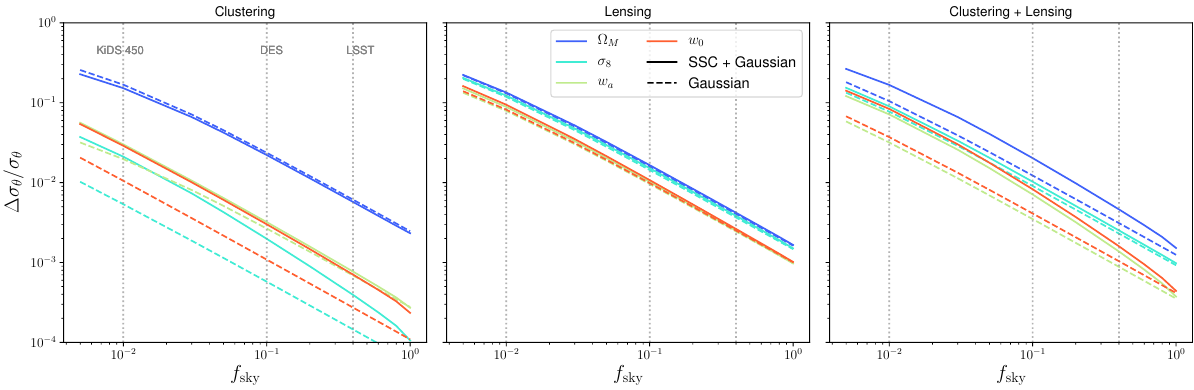
FIG. 3: Relative difference in the uncertainties on late-time cosmological parameters due to the parameter dependence of the covariance matrix as a function of survey area for a fiducial (cid:96) max = 3000. From left to right, we show results for galaxy clustering, weak lensing and for the combination of both probes. Results are shown for Gaussian covariance matrices (dashed lines) and including the super-sample covariance (solid lines). As argued in Section II, the importance of the parameter dependence grows towards smaller f sky , as the number of modes available decreases. Nevertheless, the effect is never larger than statistical errors for the smallest sky fractions ( f sky = 0 . 005), and is below 1% for LSST-like areas ( f sky